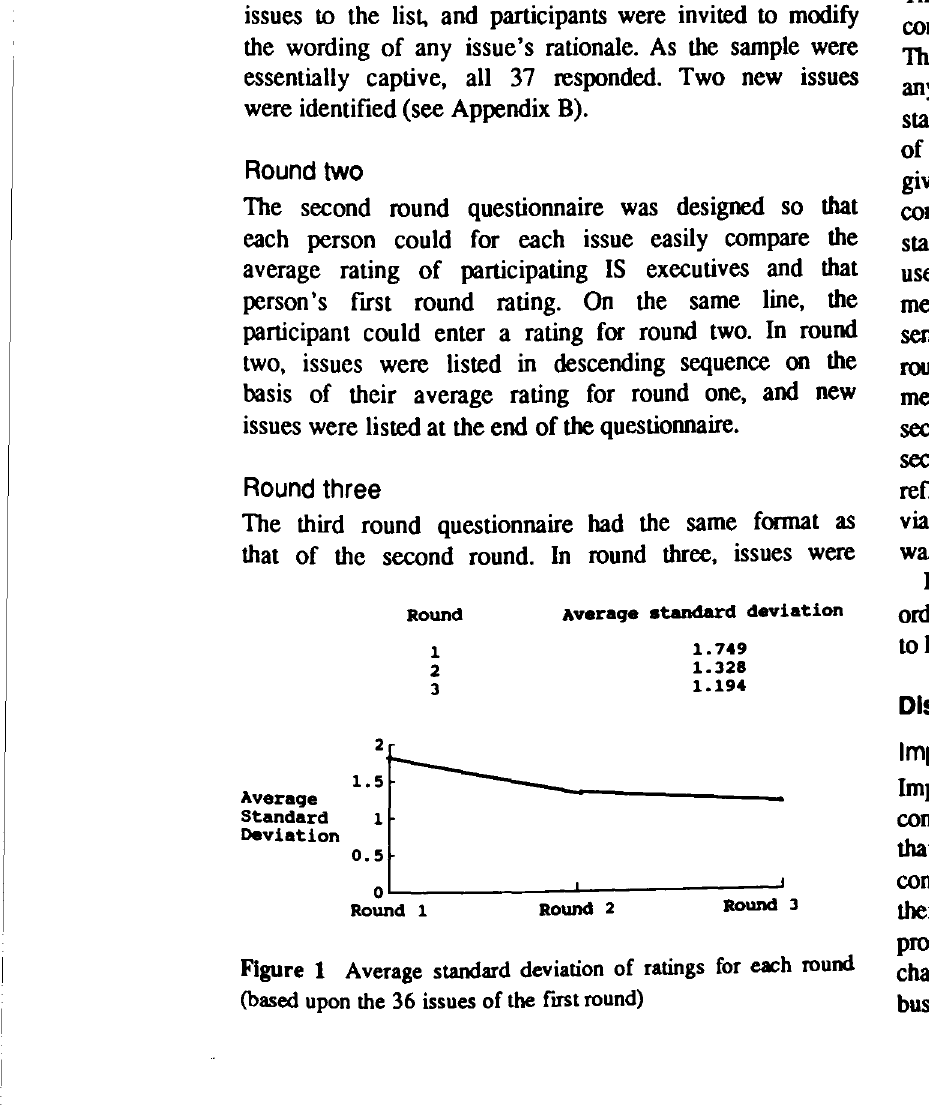
Figure 1 Average standard deviation of ratings for each round (based upon the 36 issues of the first